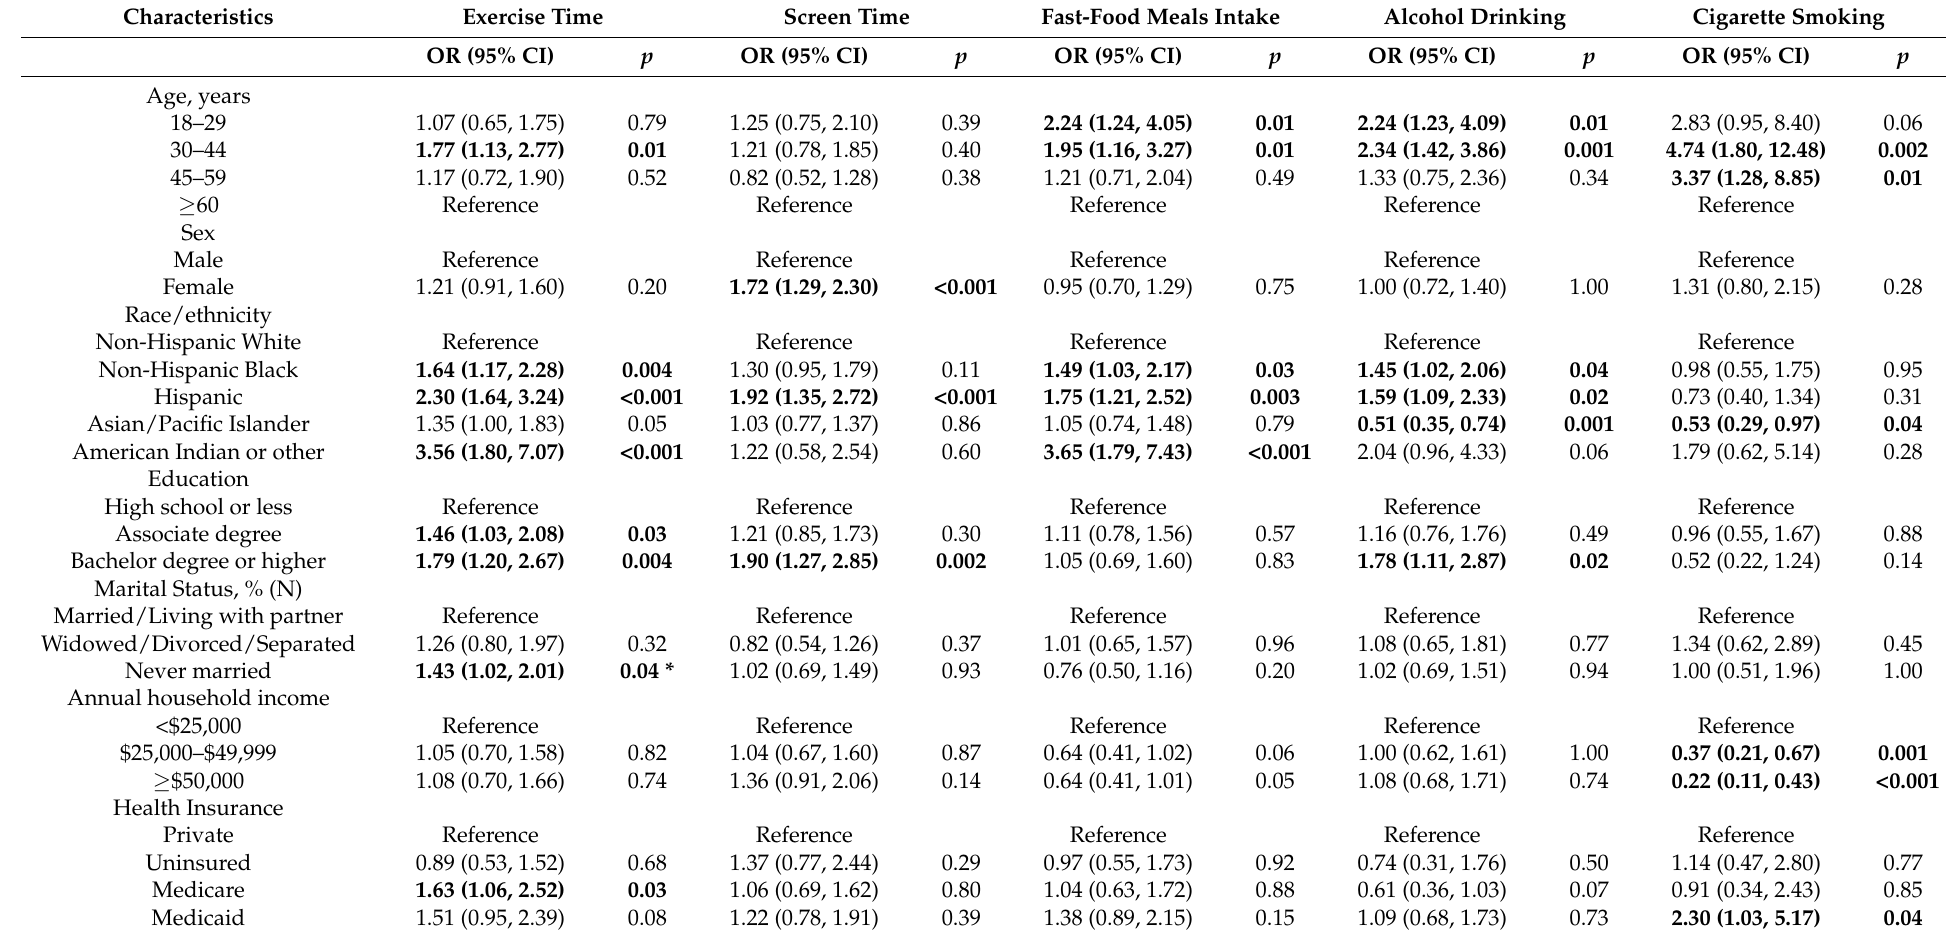
Table 3. Multivariable associations between sociodemographic variables and the undesired changes of lifestyle before and during the COVID-19